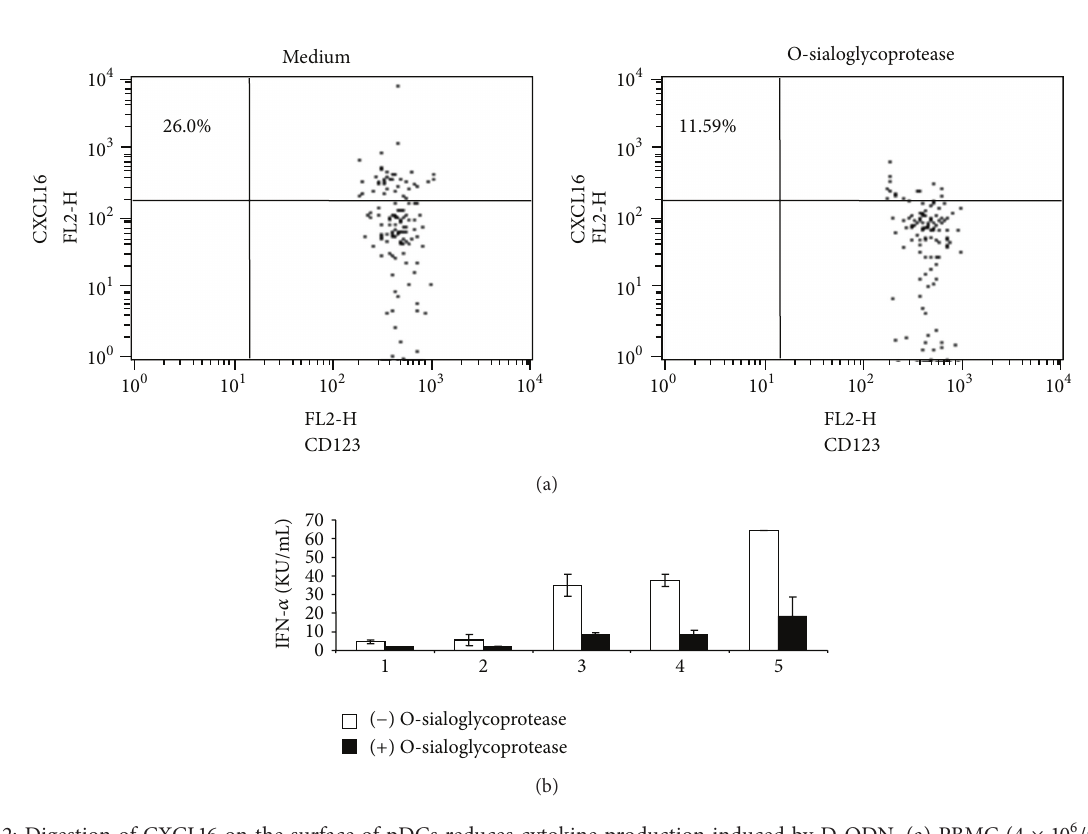
Figure 2: Digestion of CXCL16 on the surface of pDCs reduces cytokine production induced by D-ODN. (a) PBMC (4 × 10 6 /mL) were preincubated in the absence or presence of O-sialoglycoprotein endopeptidase (25 𝜇 g/mL) for 30 min, fixed, and stained for CXCL16 expression. (b) Cells treated as in (a) were washed and then stimulated with 3 𝜇 M D-ODN for 24h. Cytokine production was assessed from culture supernatants using ELISA. Response of 6 individual donors is